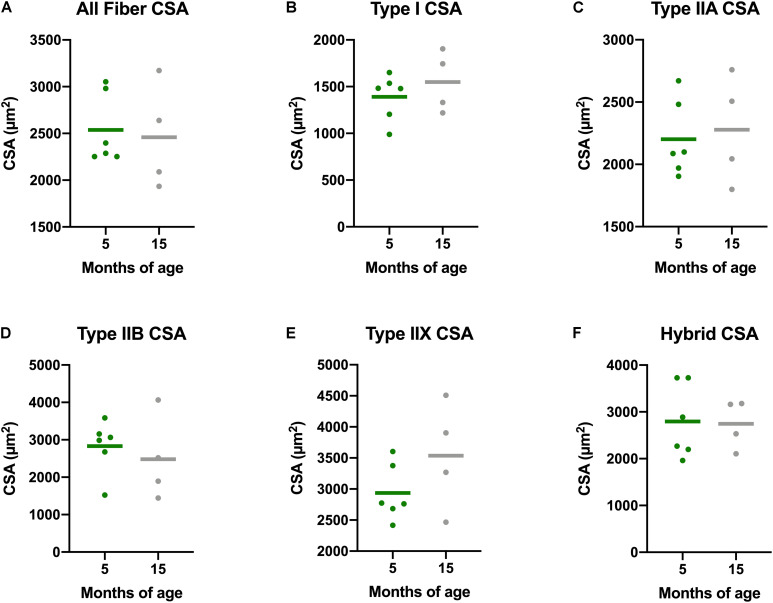
Muscle fiber type-specific CSA averages in the gastrocnemius of Dunkin Hartley guinea pigs. There were no differences between the CSA of skeletal muscle fibers of any type in the gastrocnemii of 5 mo and 15 mo Dunkin Hartley guinea pigs (A–F).